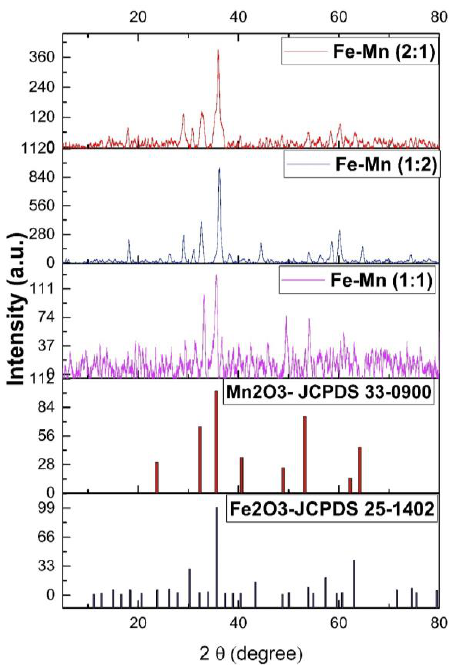
Figure 1. XRD pattern of Fe-Mn (2:1), Fe-Mn (1:2), and Fe-Mn (1:1) oxides.